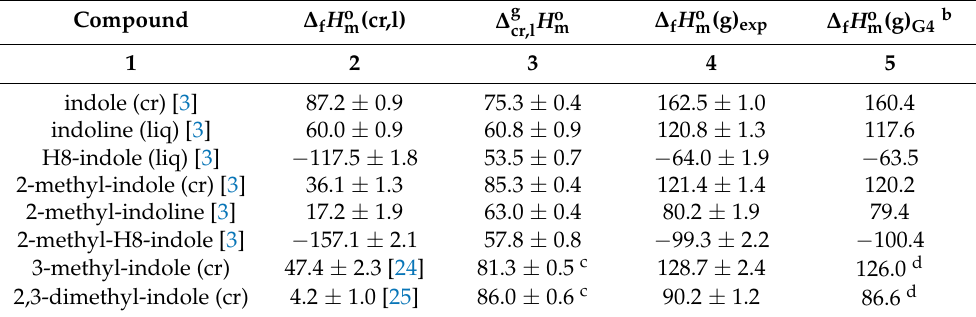
Table 1. Compilation of thermochemical data for indole derivatives at T = 298.15 K ( p = 0.1 MPa, in kJ · mol − 1 ) a . Compound ∆ f H o m (cr,l) ∆ g